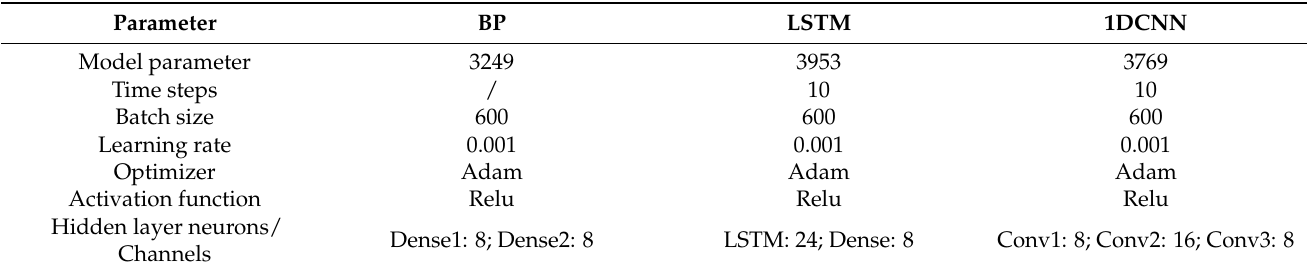
Table 4. The structure parameters of BP, LSTM and 1DCNN network model.